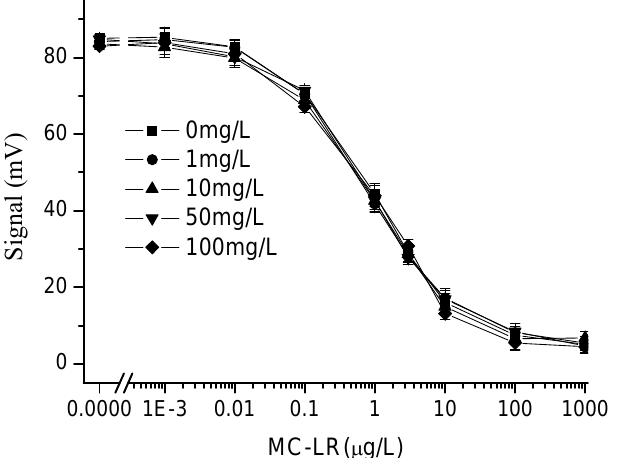
Figure 5. Effect of the humic acid on the MC-LR immunoassay based on EWAI. The concentration of humic acid ranged from 0 to 100